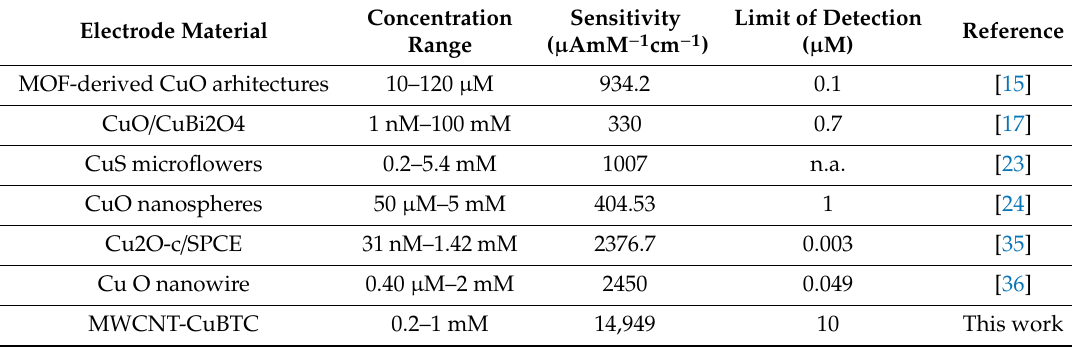
Table 3. Comparison of the performances of the MWCNT-CuBTC composite electrode with other copper-based electrodes for the non-enzymatic sensing of